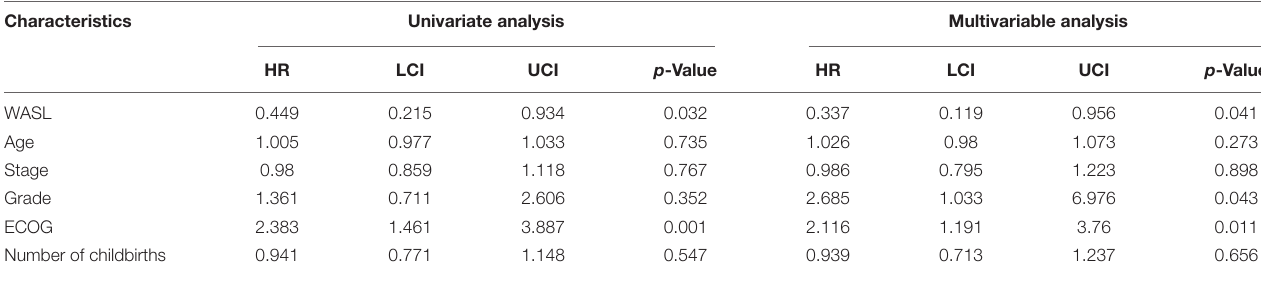
TABLE 3 | Univariate and multivariable Cox proportional hazards regression on the recurrence-free survival in TCGA-CESC.